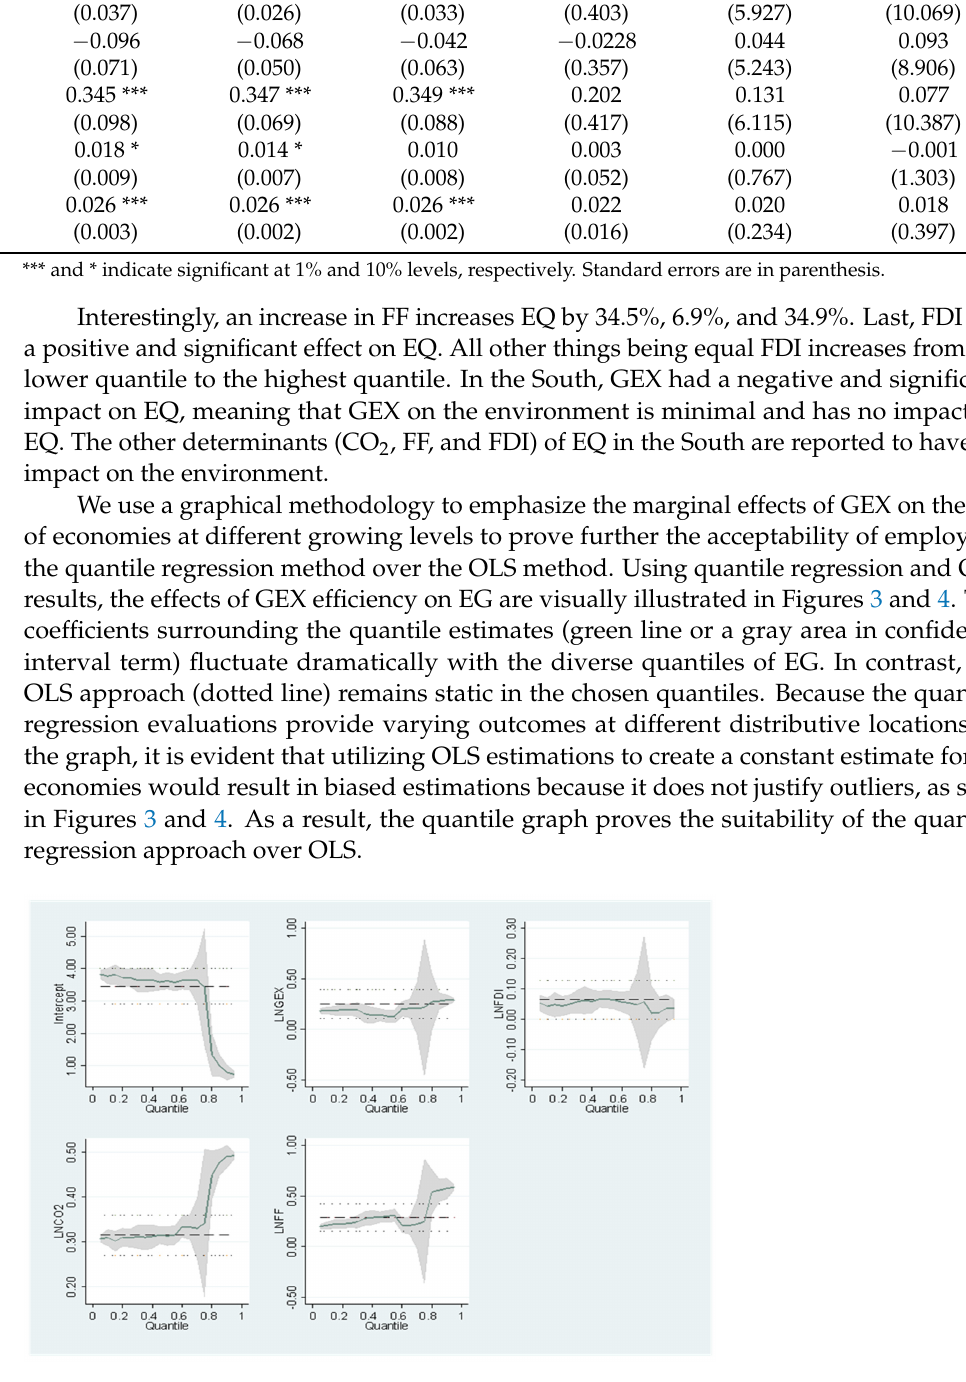
Figure 4. PQR-South. 4.1. PVAR Results The optimum lag for PVAR estimations, per Andrews and Lu [81], was among the selected lag best three criteria: MQIC, MBIC, and MAIC. Hence, we employed the GMM approach to applying the first-order lag PVAR model in its stationary version, as sug- gested by Love and Zicchino [82] and adopted by Andrews and Lu [81]. The PVAR results are shown in Table 6. In North Africa, the parameters of EG are positive and significant,